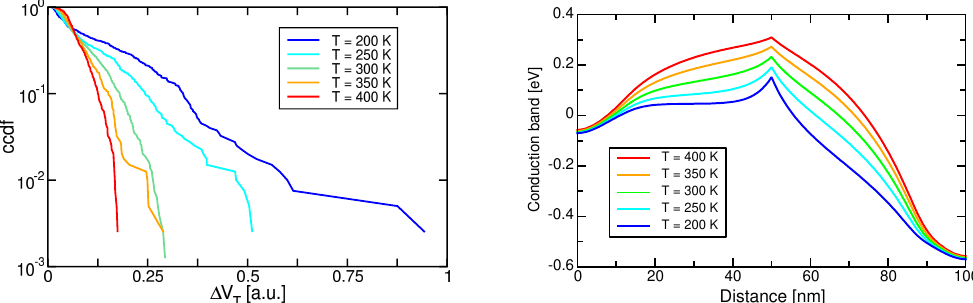
Figure 5. ( Left ) Simulation results for the RTN ccdf in a template 3D NAND device for different temperatures. ( Right ) Conduction band profile at different temperatures for a template device with a single GB located at the center of the channel.